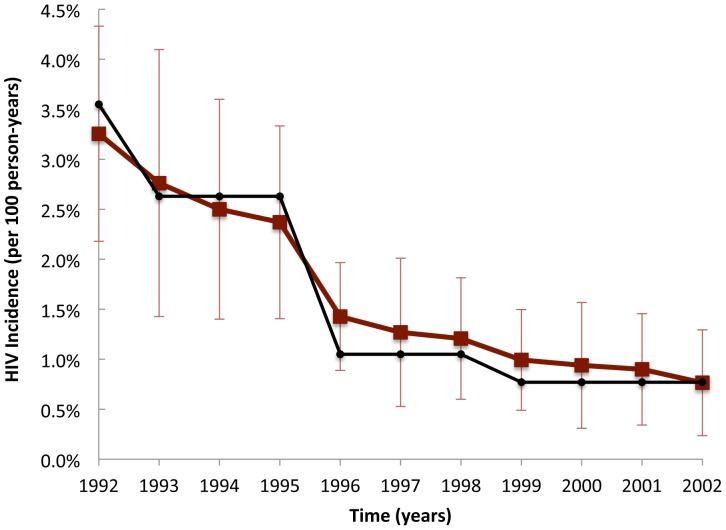
HIV incidence among IDU obtained from a Monte Carlo simulation of the agent-based model.Data shown in black represent empirically observed estimates HIV incidence among IDU in New York City [36]. Error bars represent two standard deviations of the bootstrapped estimates.